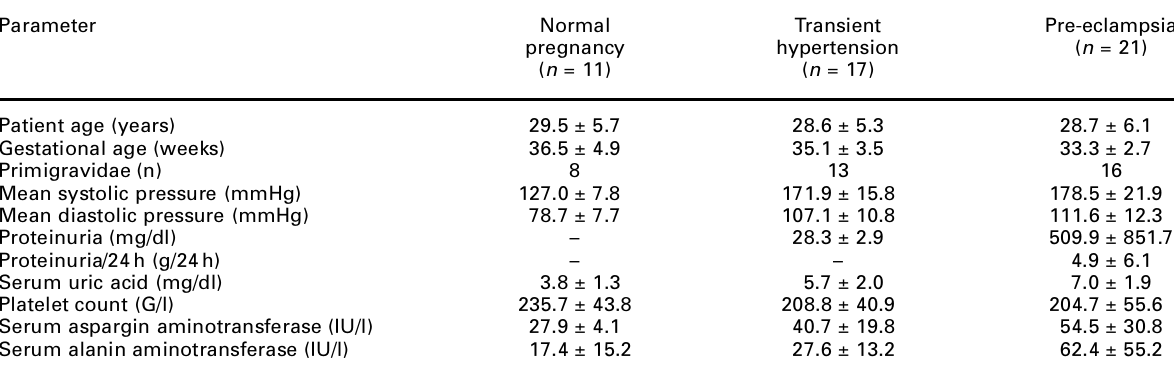
Table 1. Data from routine interview, clinical investigation, blood pressure measurements and laboratory testing in healthy pregnant women, and pregnant patients with transient hypertension and pre-eclampsia